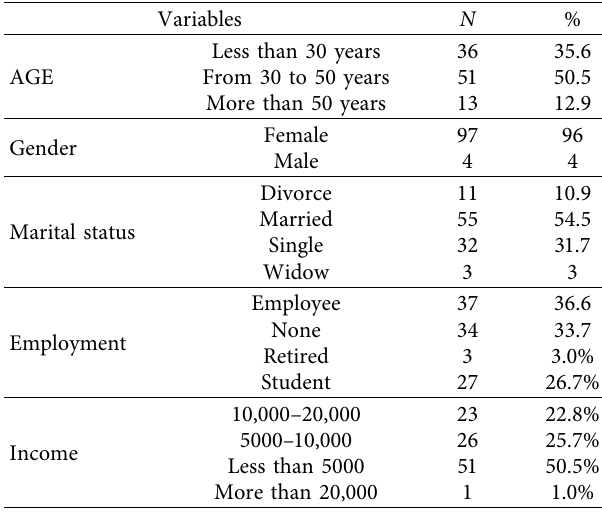
Table 1: Participants’ demographic